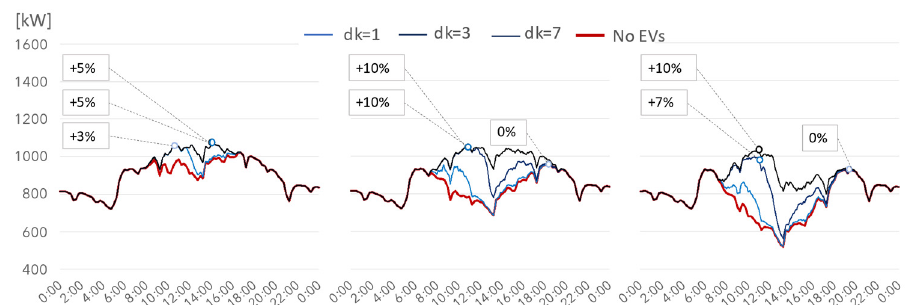
Figure 15. Comparison of the total power flows with SA ‐ CMS. The red curves are the PV power, the blue curves are 𝑃 (cid:3006)(cid:3023)(cid:3046) with 𝑑 (cid:3038) = [1;3;7], while the dotted blue curves are the standard (No ‐ CMS) EV load profiles. The colorized areas show the self ‐ consumption energy according to the PV generation conditions: worst condition ( left ), the mean condition ( center ), and the best condition ( right )